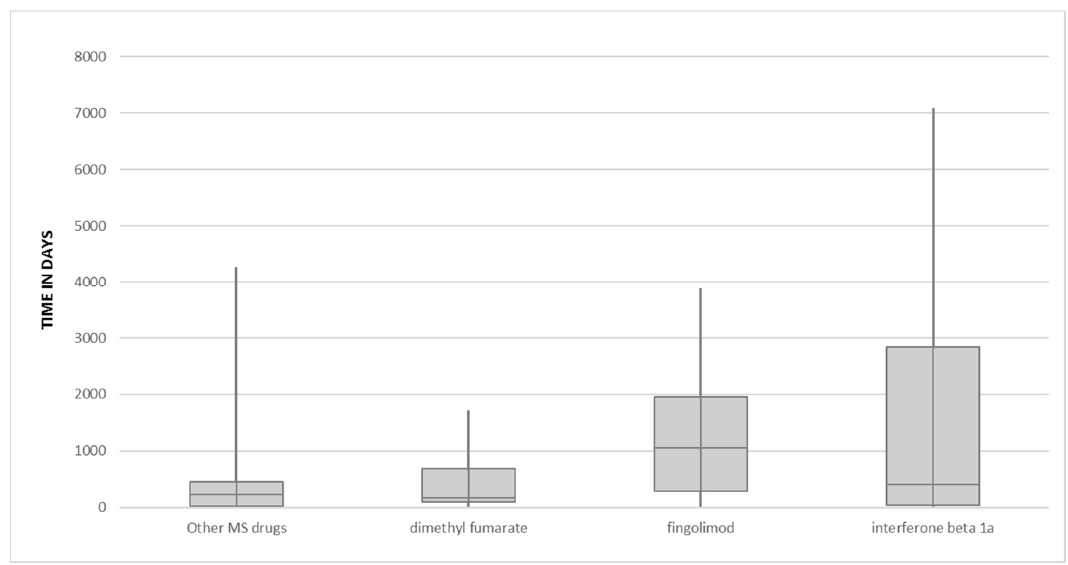
Figure 1. Box plot of median Time to Event in days for dymethil fumarate, fingolimod, interferon beta 1a and other multiple sclerosis (MS) drugs.